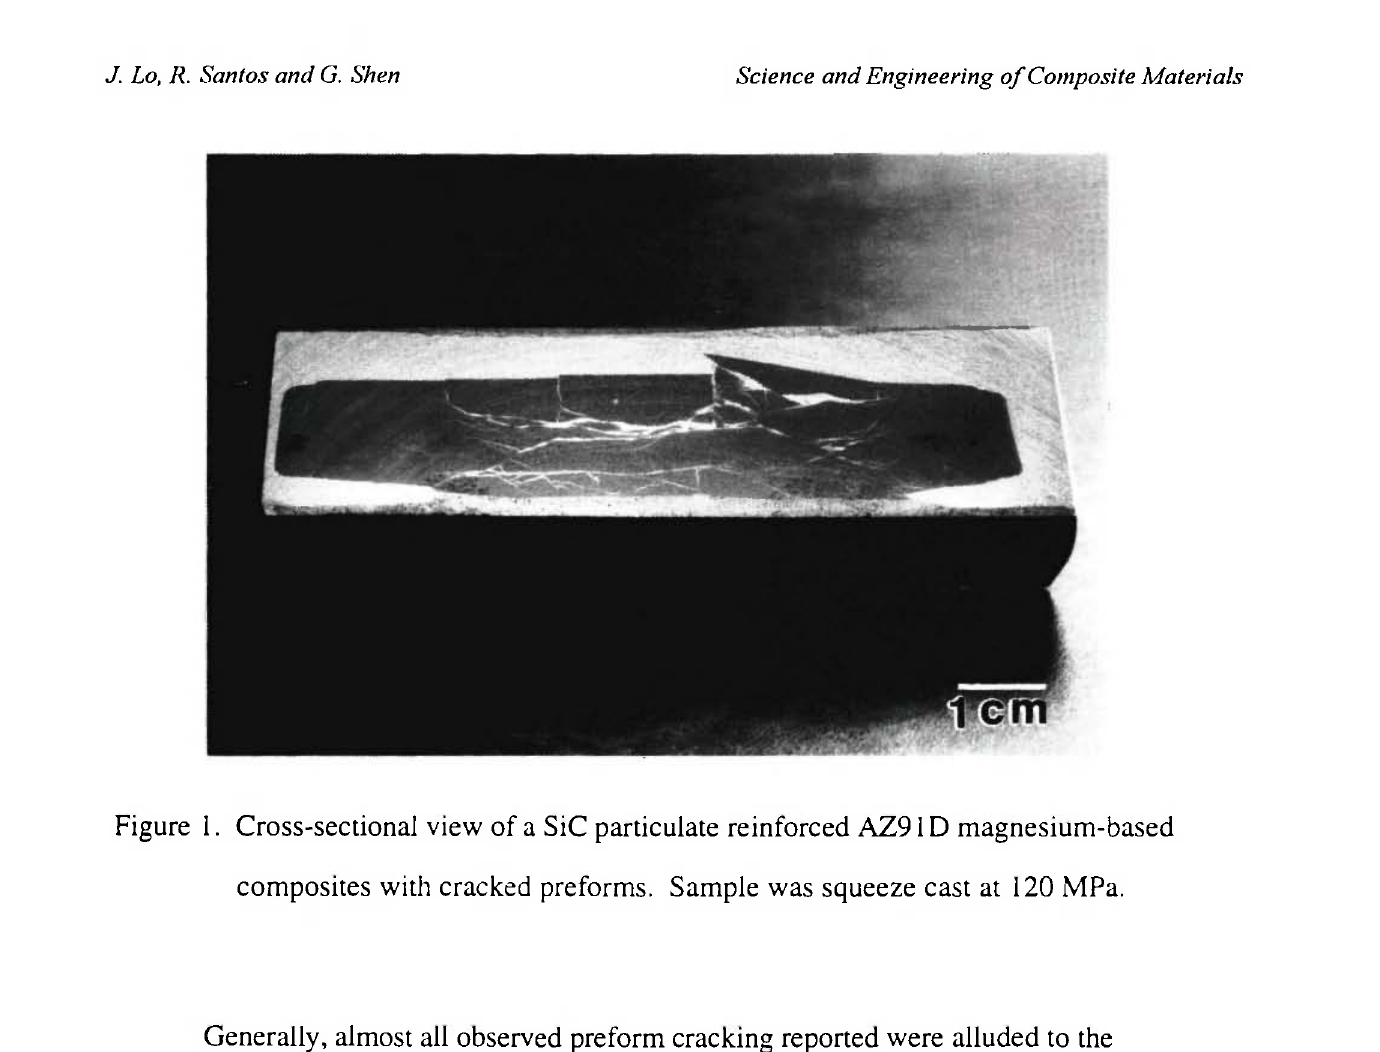
Figure 1. Cross-sectional view of a SiC particulate reinforced AZ91D magnesium-based composites with cracked preforms. Sample was squeeze cast at 120